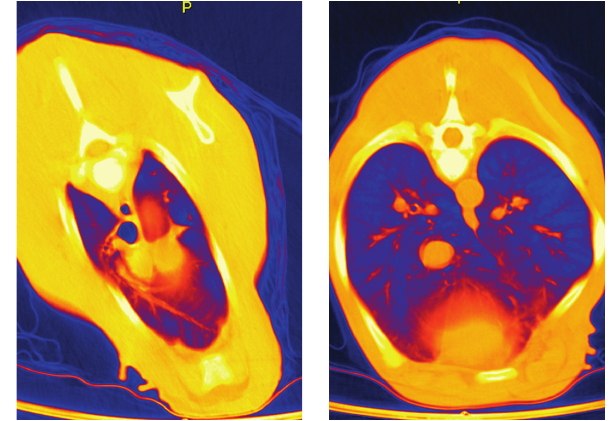
Figure 9: CT: thorax layer in false-color representation of a subject of group A at 2 weeks p. n.